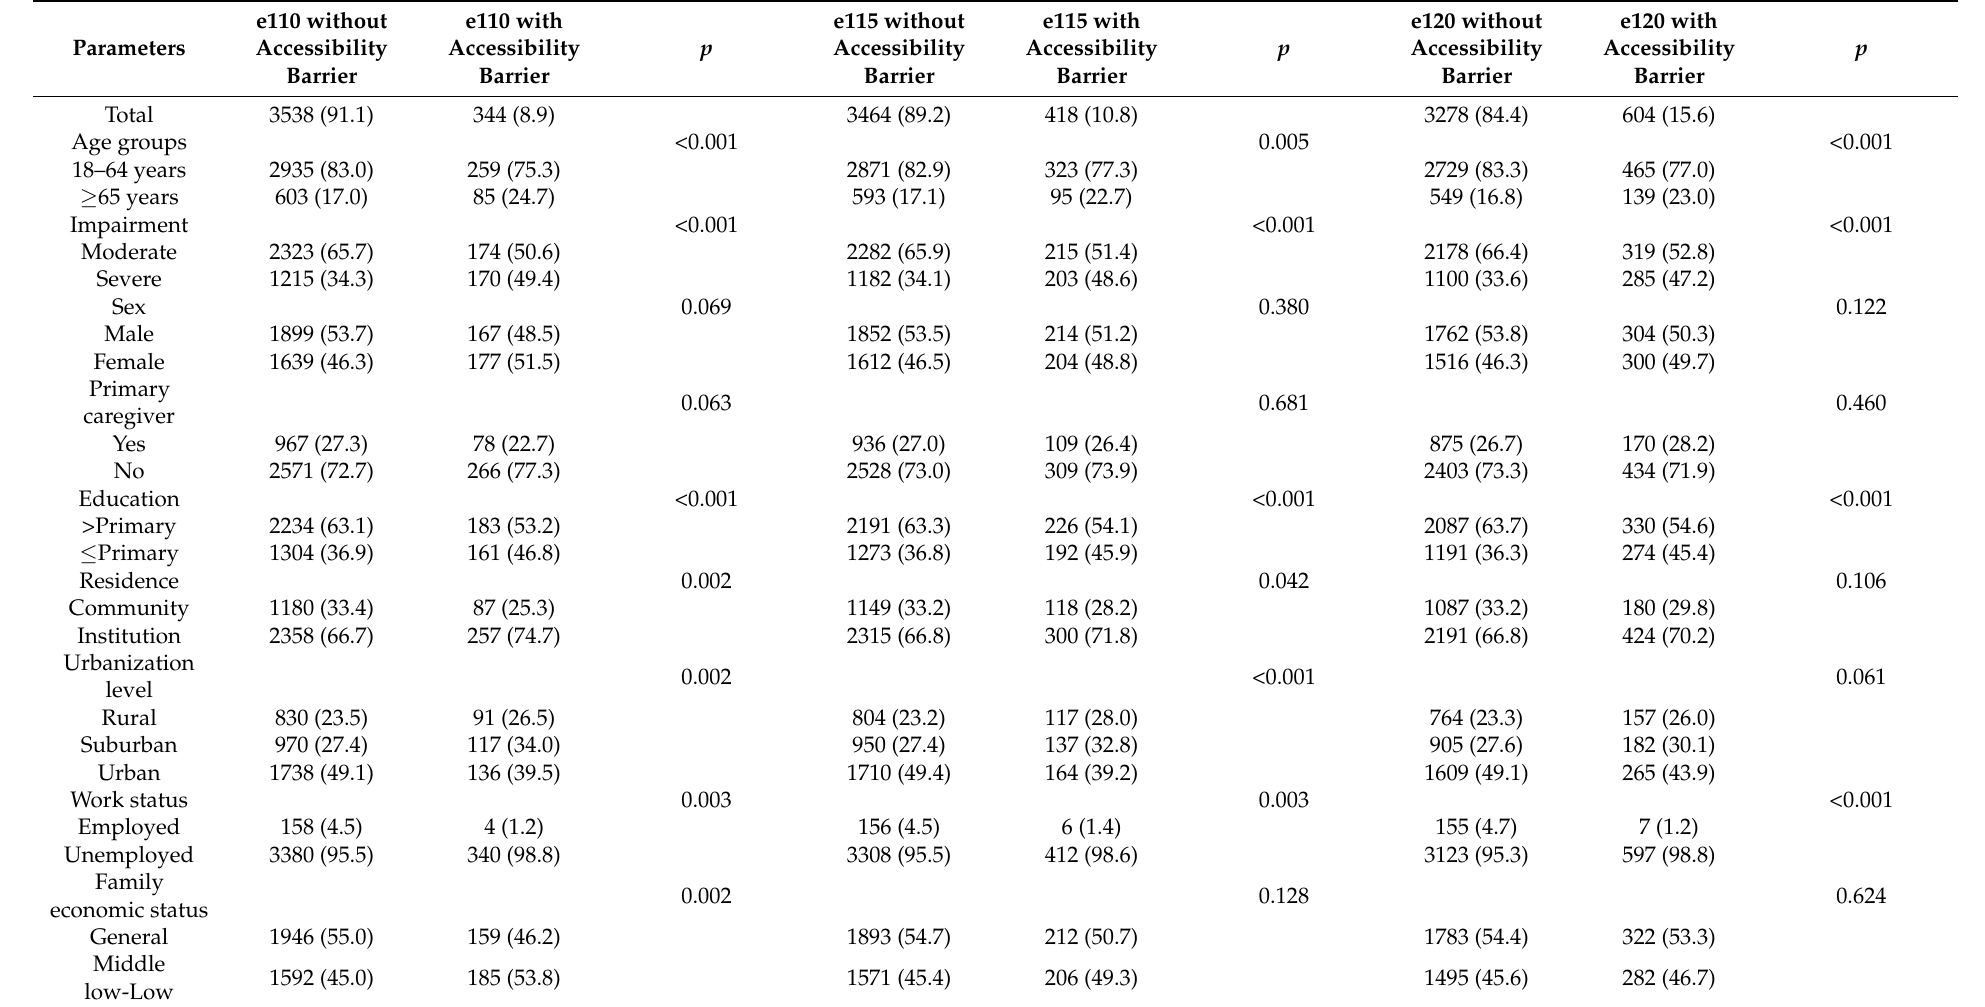
Table 3. The sociodemographic allocation and comparison of the patients with schizophrenia without and with accessibility barriers in the categories of chapter e1 products and